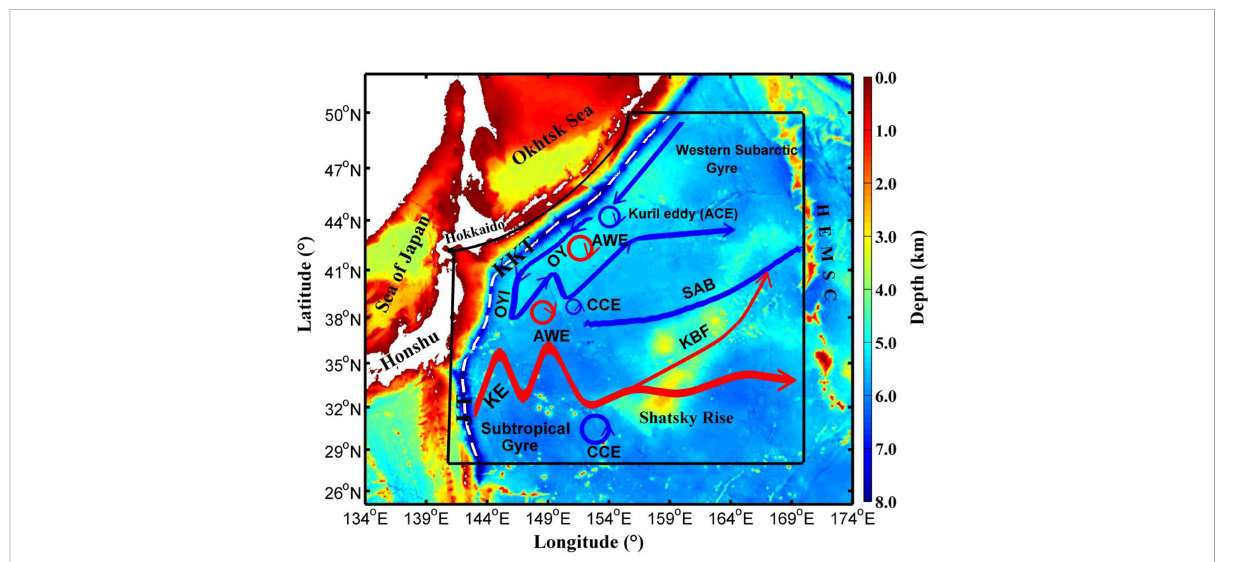
FIGURE 1 Geography and hydrography of the Kuroshio – Oyashio Extension region (black polygon area). The background color indicates water depth (units: km), and the white dotted line indicates the Japan Trench (JT) and Kuril-Kamchatka Trench (KKT). The symbols “ OY ” , “ OYI ” , “ KE ” , “ CCE ” , “ AWE ” , “ ACE ” , “ SAF ” , “ KBF ” , “ HEMSC ” stand for Oyashio Current, southward intrusion of the Oyashio, Kuroshio Extension, cyclonic cold-core eddy, anticyclonic warm-core eddy, anticyclonic cold-core eddy, Subarctic Front, the Kuroshio Bifurcation Front, and the Hawaii-Emperor Sea mount chain,